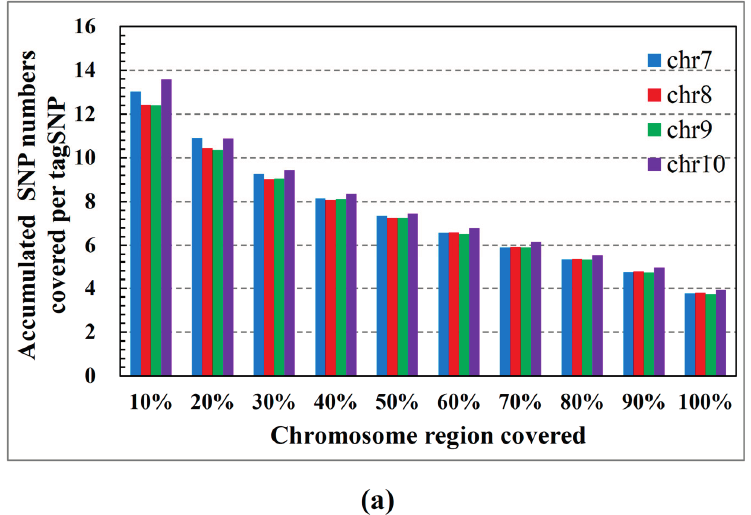
Figure 2. TagSNPs required to cover 10% increments of the chromosomal region: ( a ) number of TagSNPs and ( b ) percentage of